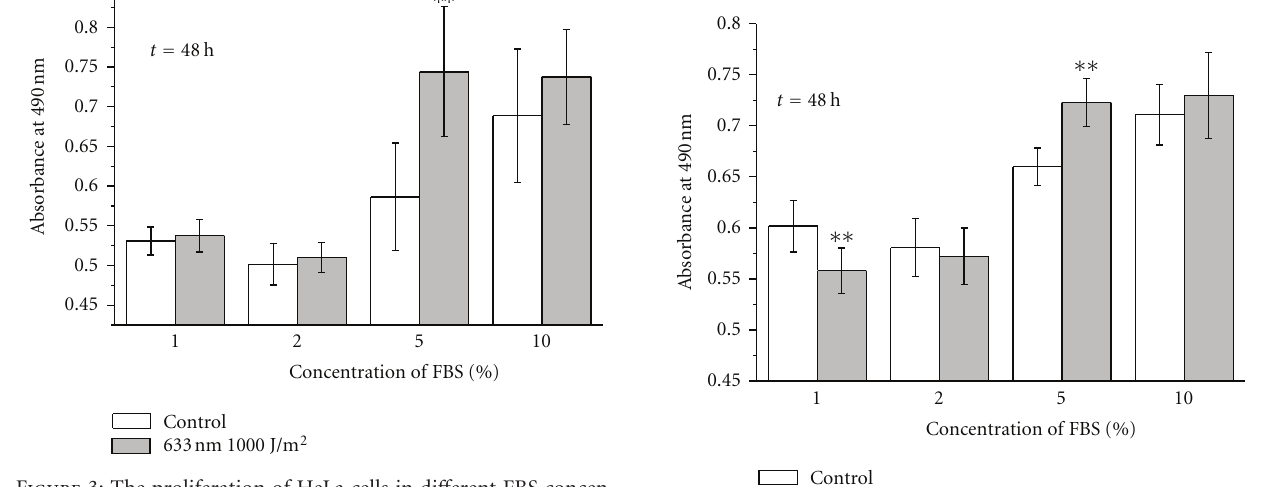
Figure 3: The proliferation of HeLa cells in di ff erent FBS concen- trations (laser wavelength λ = 633nm, energy density 1000 J/m 2 , irradiation time 100 s). The absorbance value was assessed at 48h after laser irradiation. Error bars were from three independent experiments, ∗∗ P < 0 . 01.